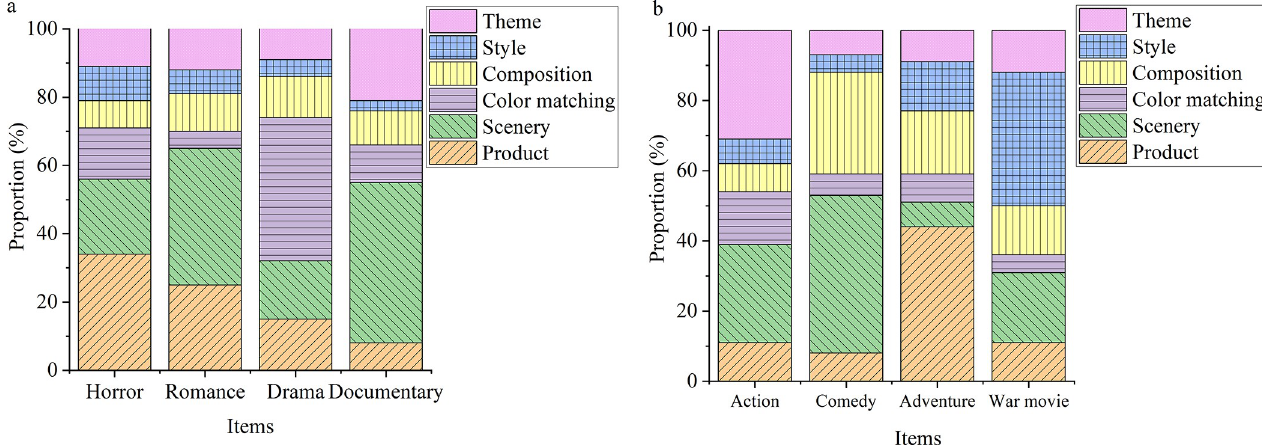
Fig 7. The style composition of film posters analyzed by the DCNN model based on BDT (a: Group one, b: Group two).